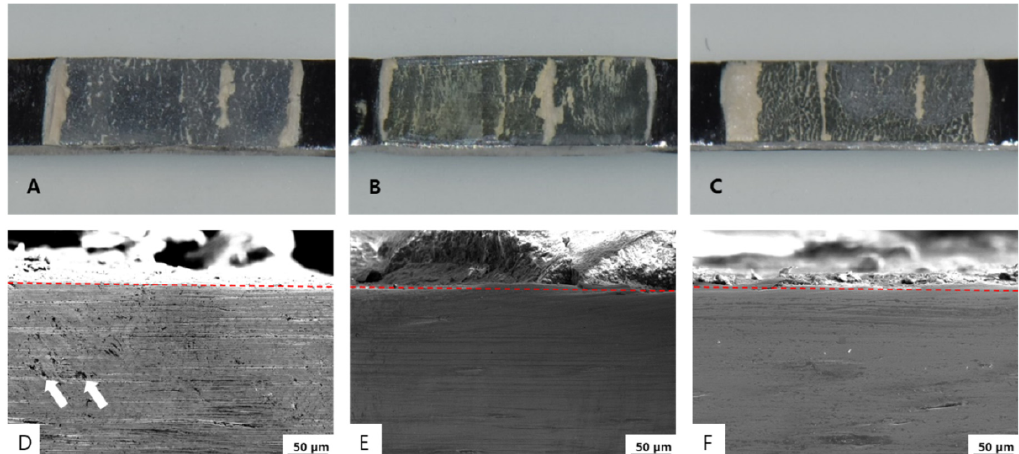
Figure 11. ( A – C ) Metal-Ceramic failure surface after separation of the ceramic layer: ( A ) casting, ( B ) milling, and ( C ) SLM specimens. ( D – F ) Cross-sectional SEM image of Metal-Ceramic specimens after debonding of the ceramic: ( D ) casting (the white arrows indicate defects), ( E ) milling, and ( F ) SLM specimens. Red dotted lines indicate the Metal-Ceramic boundaries.